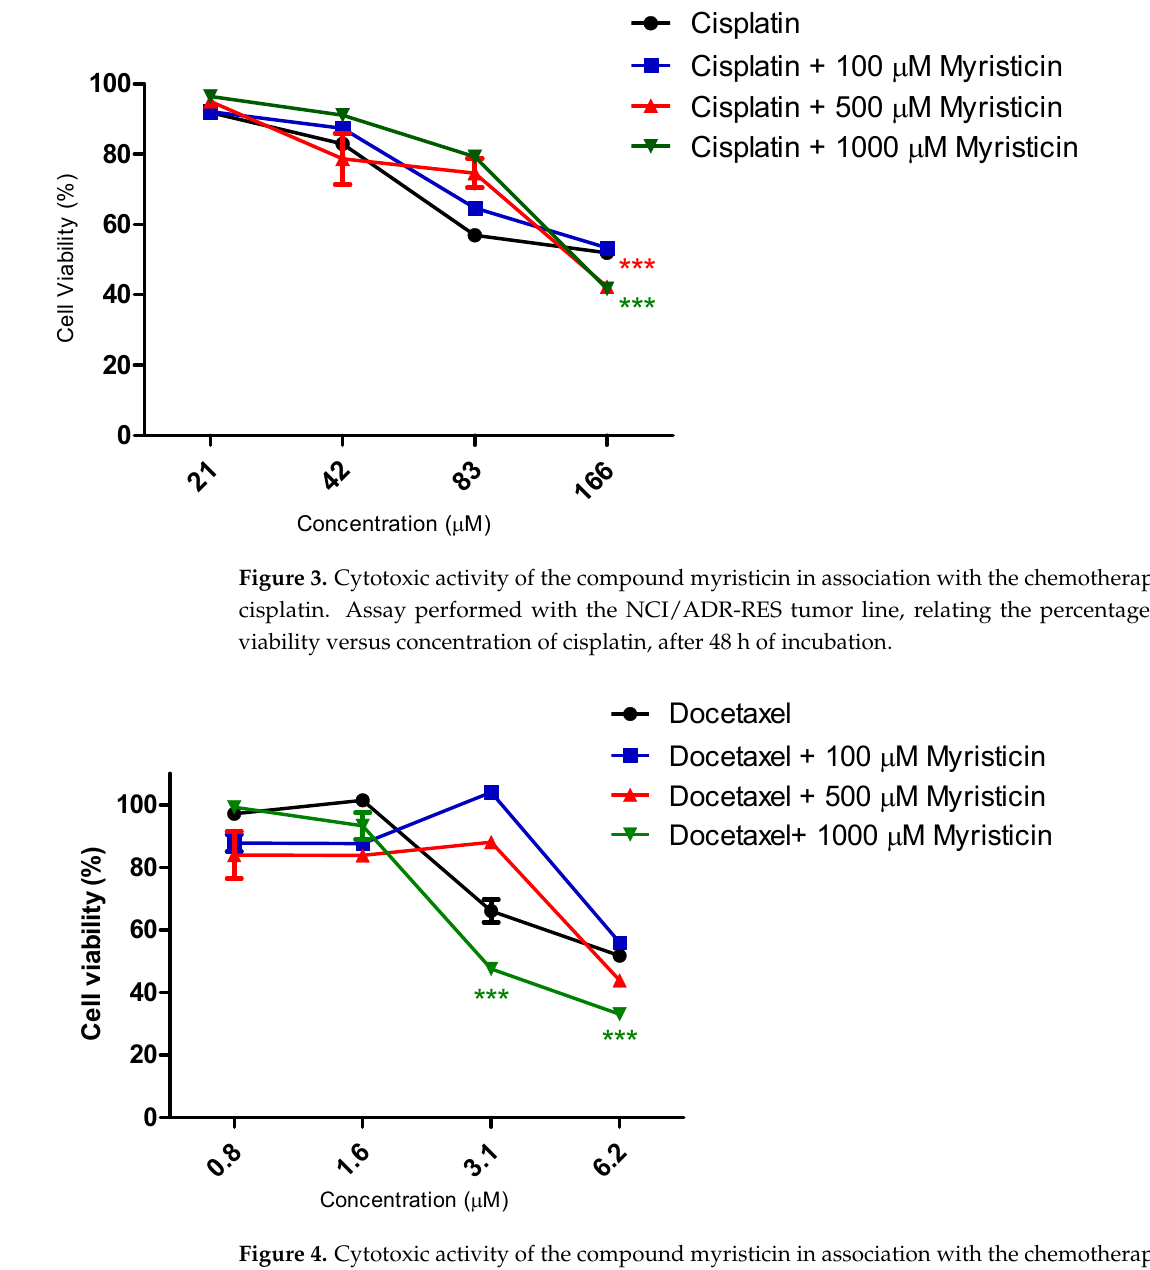
Figure 4. Cytotoxic activity of the compound myristicin in association with the chemotherapy drug docetaxel. Assay performed with the NCI/ADR-RES tumor line, relating the percentage of cell viability versus concentration of docetaxel, after 48 h of incubation.